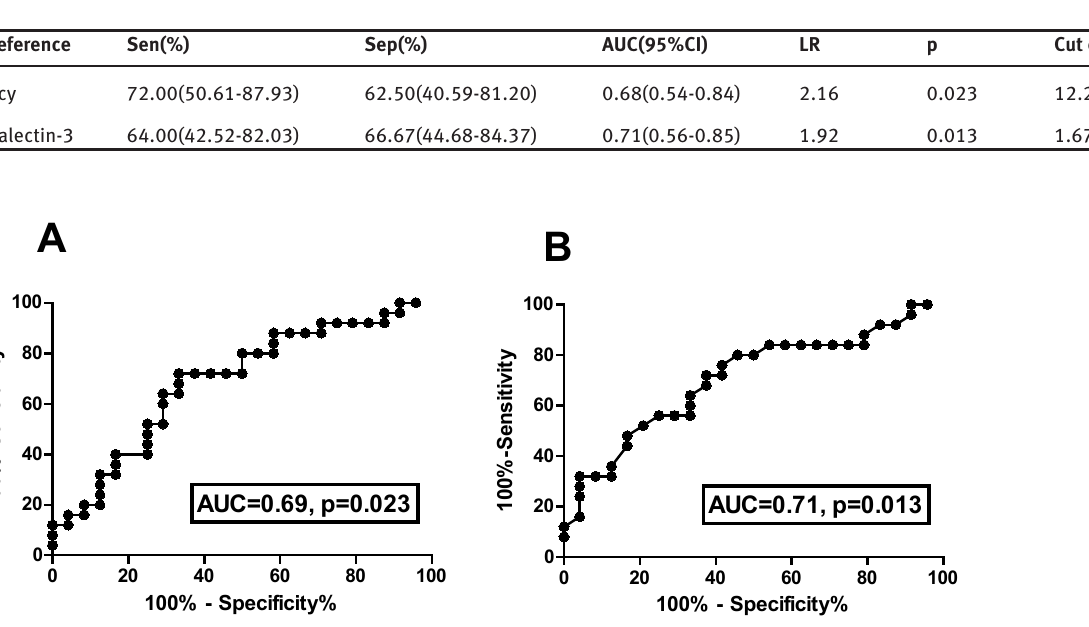
Figure 4: Roc curve for serum Hcy and Galectin-3 as biomarker for diagnosis of PeAF(A:serum Hcy in diagnosis of PeAF; B: serum Galectin-3 in diagnosis of